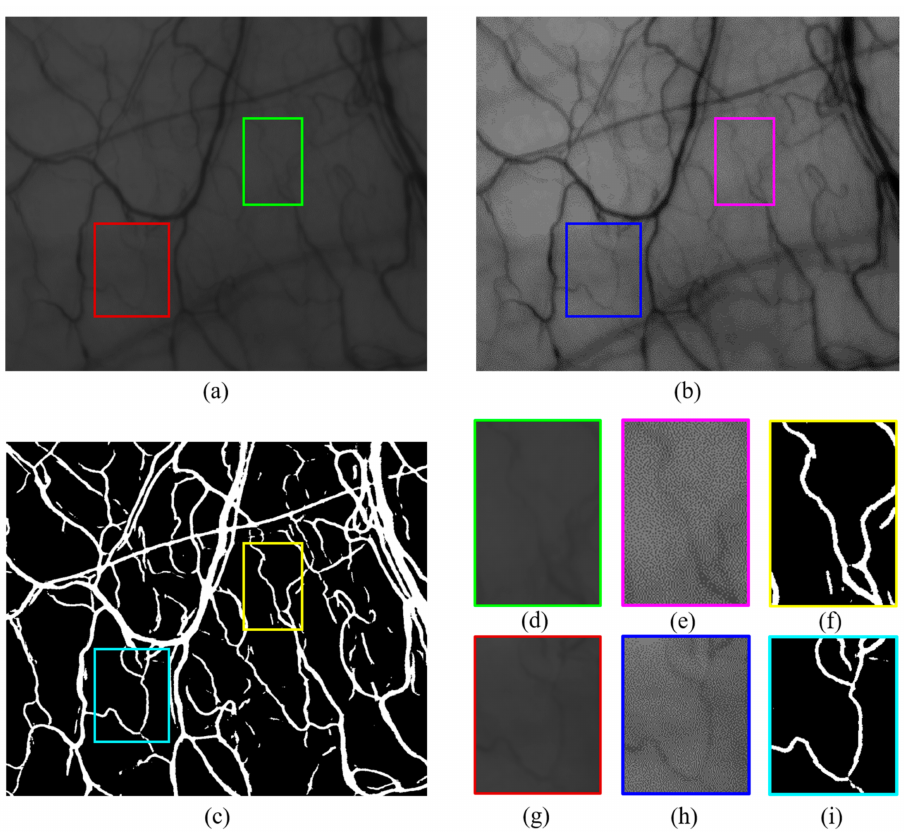
Figure 6. ( a ) Averaged conjunctival image. ( b ) Brightness and contrast-adjusted ( a ) by Image J (set display range: 25–115). ( c ) Attention-UNet segmentation results. ( d , g ) Cropped images from the low-contrast, blurry areas of ( a ). ( e , h ) Cropped images from ( b ). ( f , i ) Corresponding to the prediction results of ( d , g ). Brightness and contrast-adjusted images ( b , e , h ) were placed to provide easier visibility for the reader.